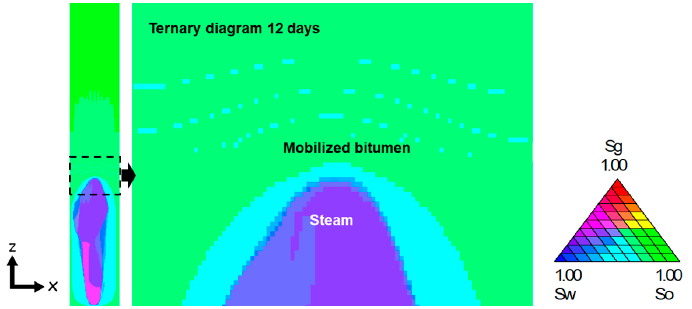
Figure 12. Cross section of the ternary diagram for the VE model. A section of the 2D image indicated by black dashed square has been zoomed in.